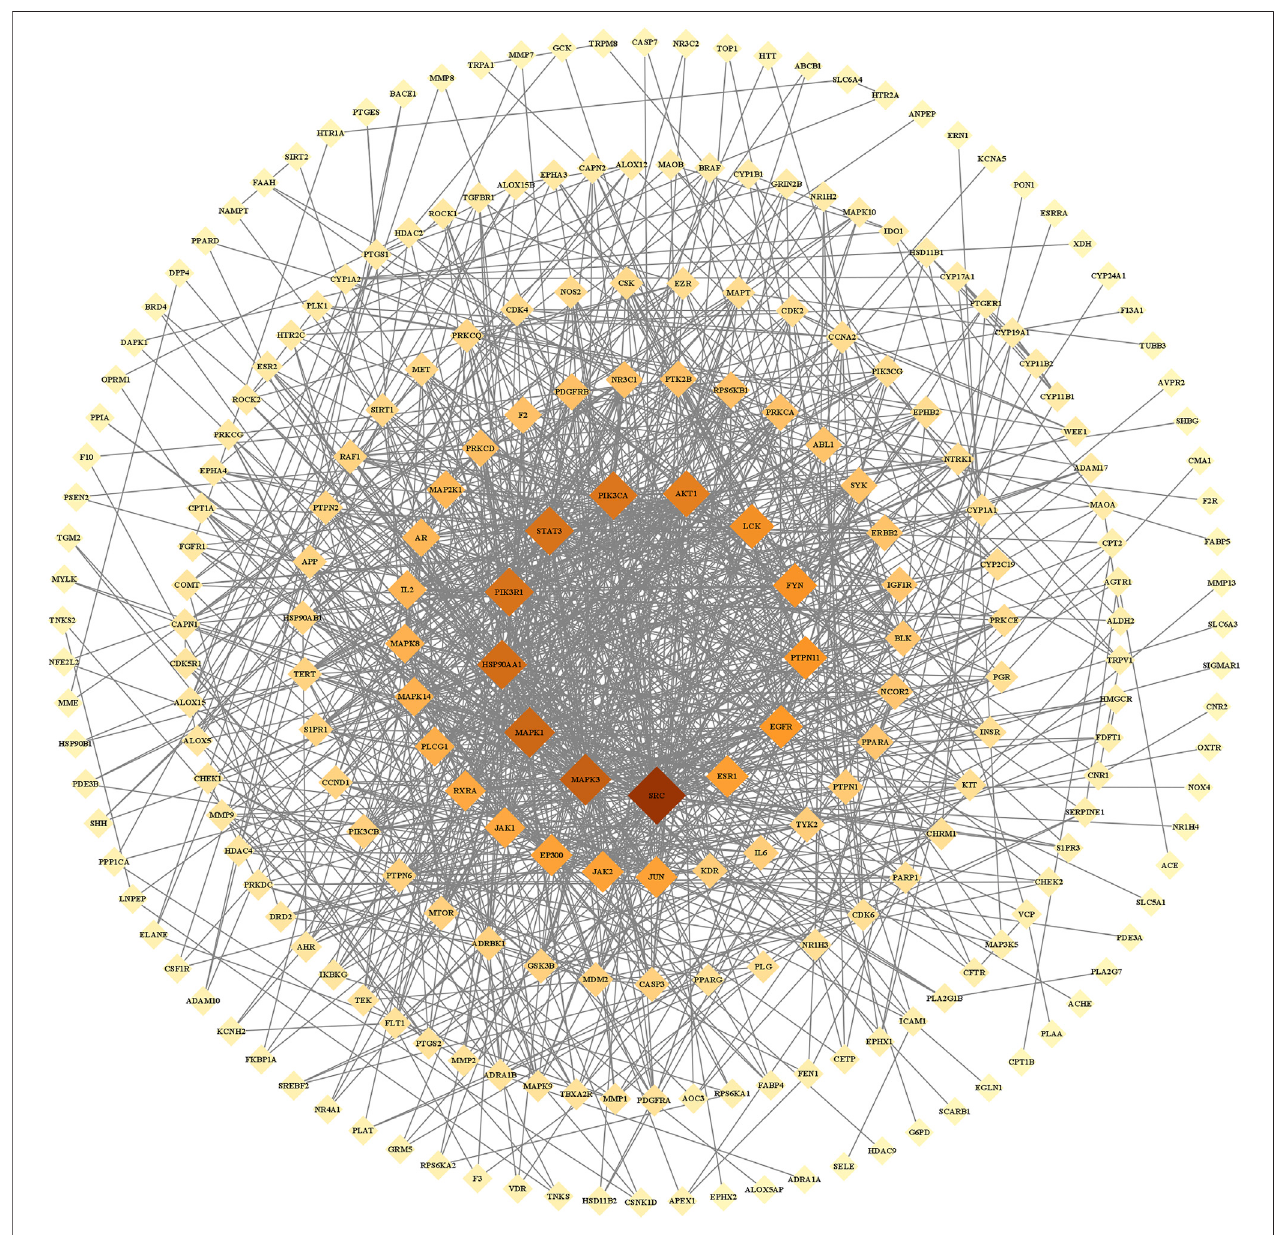
FIGURE 2 | Protein-protein interaction network of the core proteins targeted by the new formulation for the treatment of ischemic stroke with Qi de fi ciency and blood stasis syndrome. The network included 244 nodes and 1,081 edges. Diamonds repr6+ the target proteins, with darker colors indicating increasing importance.